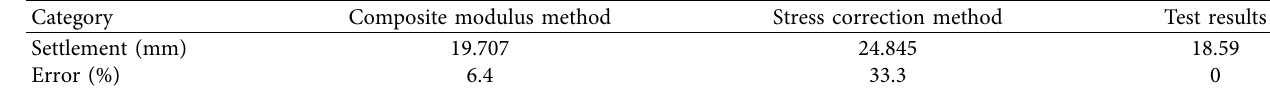
Table 7: Comparison of settlement calculation results.